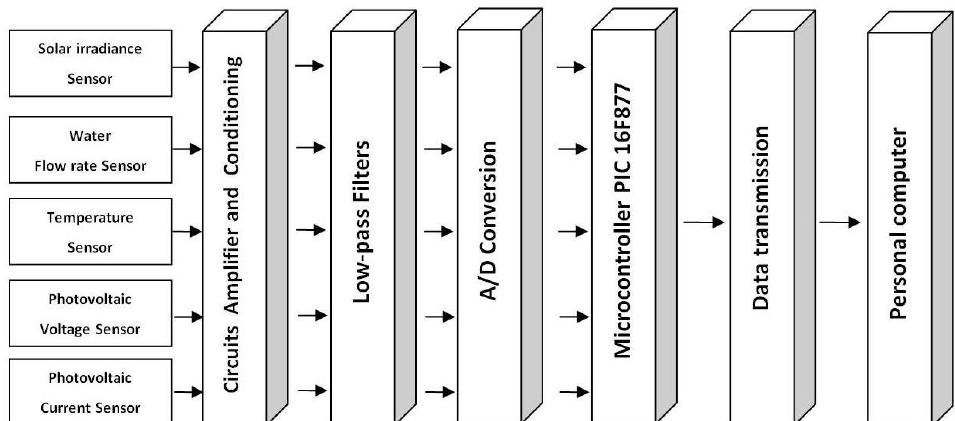
Figure 11. The sensors and interface electronic circuits in the remote